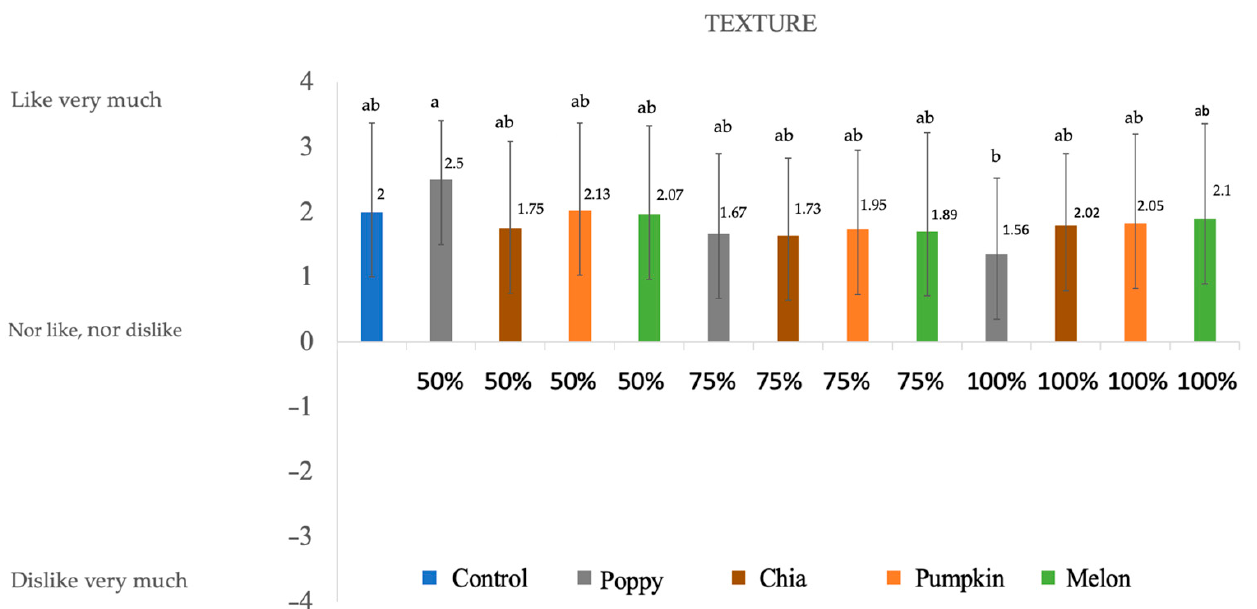
Figure 2. Results obtained in the sensory evaluation for texture. Numbers are mean ± standard error. Different letters in the same column for each attribute indicate statically differences ( p < 0.05).